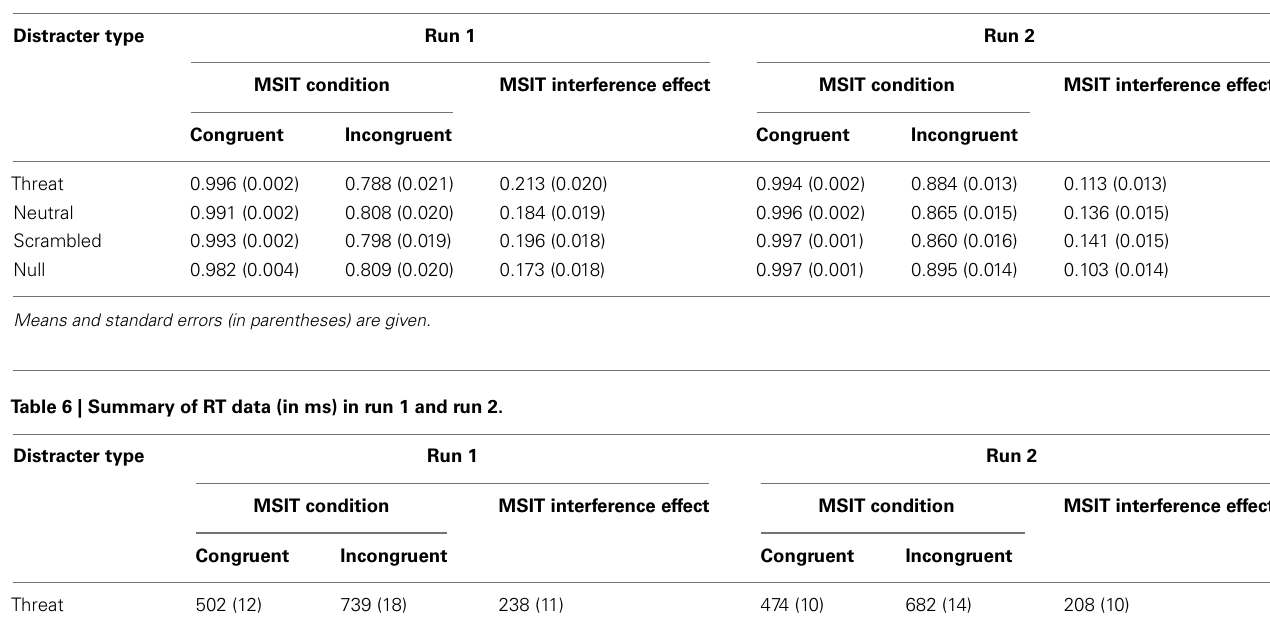
Table 5 | Summary of accuracy data (in proportion accurate) in run 1 and run 2.